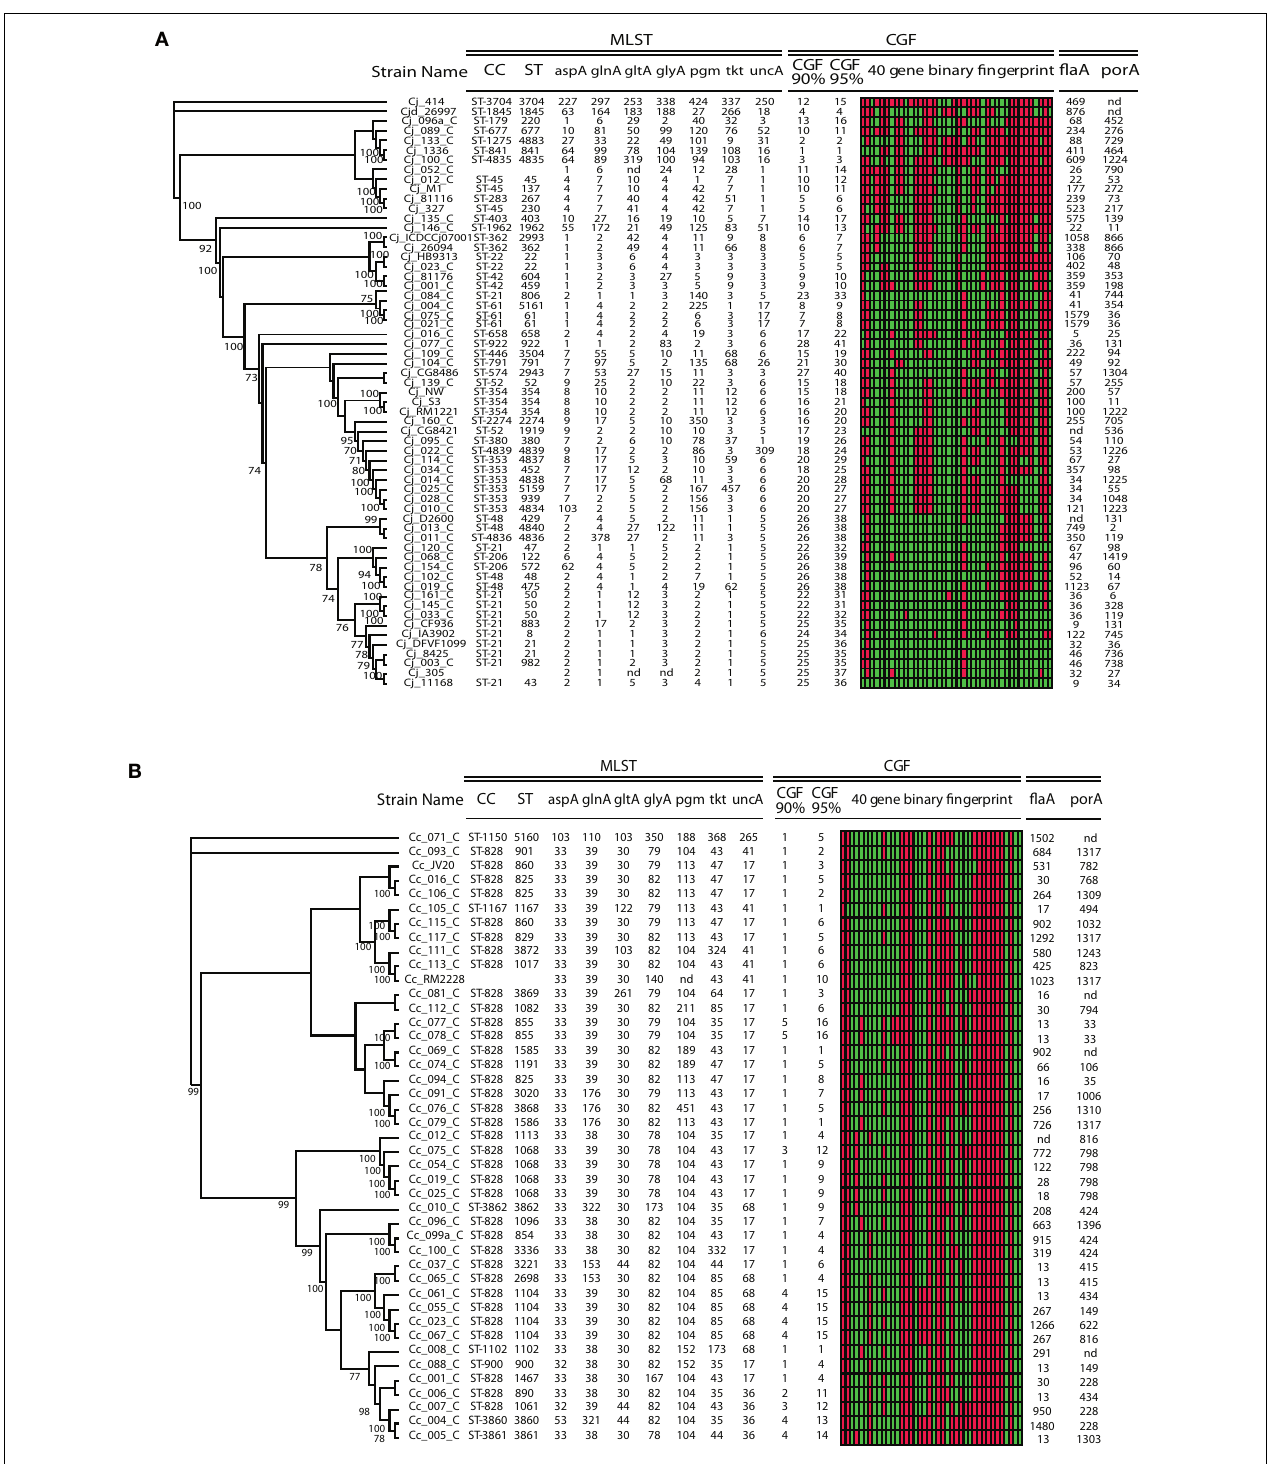
typing and phylogenetic data: strains sharing similar/identical molecular fingerprints were found clustered in the dendrogram and increasing similarity led to shorter branch lengths. CGF cluster numbers are based on 90 and 95% fingerprint identity; green is positive, red is negative. MLST alleles that could not be determined are noted as